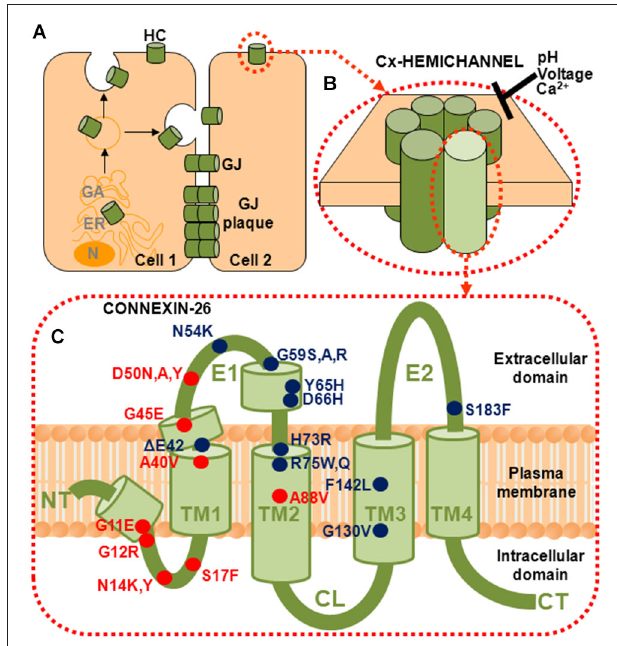
FIGURE 1 | Connexins (Cxs) form gap junction (GJ) channels and hemichannels (HCs). (A) GJ channels are formed by of docking of two HCs from neighboring cells. GJ channels cluster into plaques and provide a direct intercellular communication pathway between cells. (B) HCs, also called connexons, can function in the plasma membrane in the absence of docking. They are hexamers of six Cx subunits and are strongly regulated by pH, voltage and divalent cations, principally Ca 2 + . (C) Topology of a Cx subunit. The amino (NT) and carboxy (CT) domains are oriented to the cytoplasm. The NT domain loops back into the membrane to contribute to the aqueous pore. There are four helical transmembrane domains (TM1–TM4) and two extracellular loop domains, E1 and E2. The short helical segments in NT and E1 identified in the crystal structure are also shown (Maeda et al., 2009). Locations of the 18 residues that have been associated with mutations causing syndromic deafness are indicated; those associated with KID syndrome are indicated in